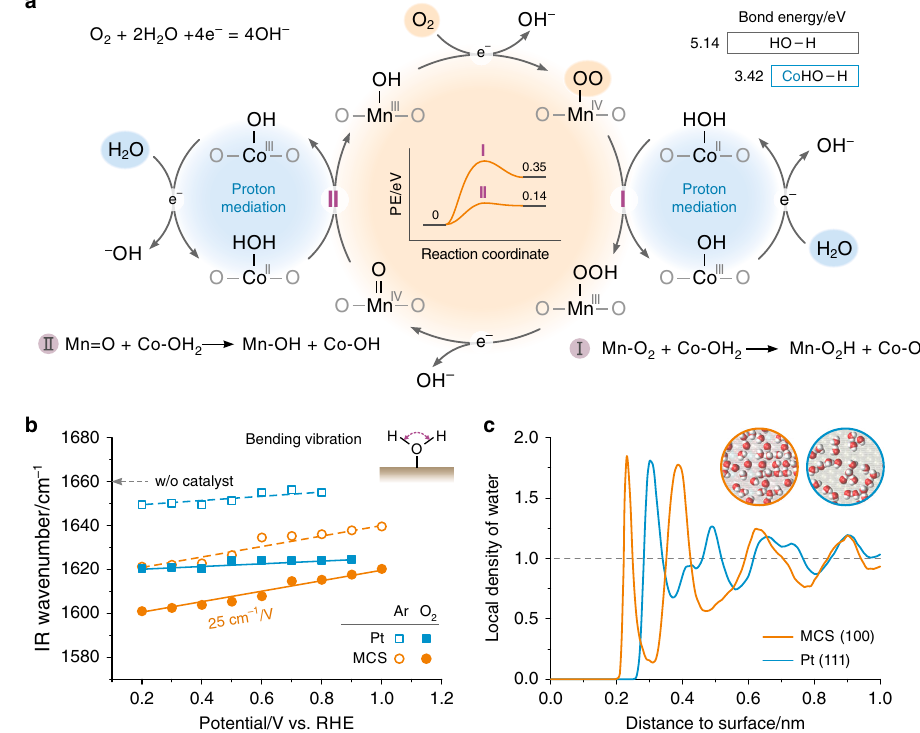
Fig. 4 Reaction mechanism involving water activation. a Schematic illustration of the proposed synergistic mechanism of ORR on MCS, featuring the dissociative reduction of O 2 at the Mn site, the proton mediation by the Co site, and the surface proton transfer in between (reactions I and II). Inset central: DFT-calculated energy barriers for reactions I & II on MCS (100) (See Supplementary Tables 7 and 8 for details). Inset upper-right: DFT-calculated bond energies of O – H in H 2 O and Co-OH 2 . b Results of in situ attenuated total re fl ection Fourier transform infrared (ATR-FTIR) studies for MCS and Pt electrodes in Ar or O 2 saturated KOH solutions. See Supplementary Fig. 14 for relevant FTIR spectra. The IR signals of interest were from the bending vibration of H 2 O (inset). The Stark effect (wavenumber shift with potential) is a measure of the H 2 O adsorption on the surface. c Local density of water on MCS (100) and Pt (111) surfaces at 300 K, obtained from atomistic molecular dynamics (MD) simulations (also see Supplementary Fig. 15). Inset: Snapshots of water molecules in a surface layer up to 0.3 nm